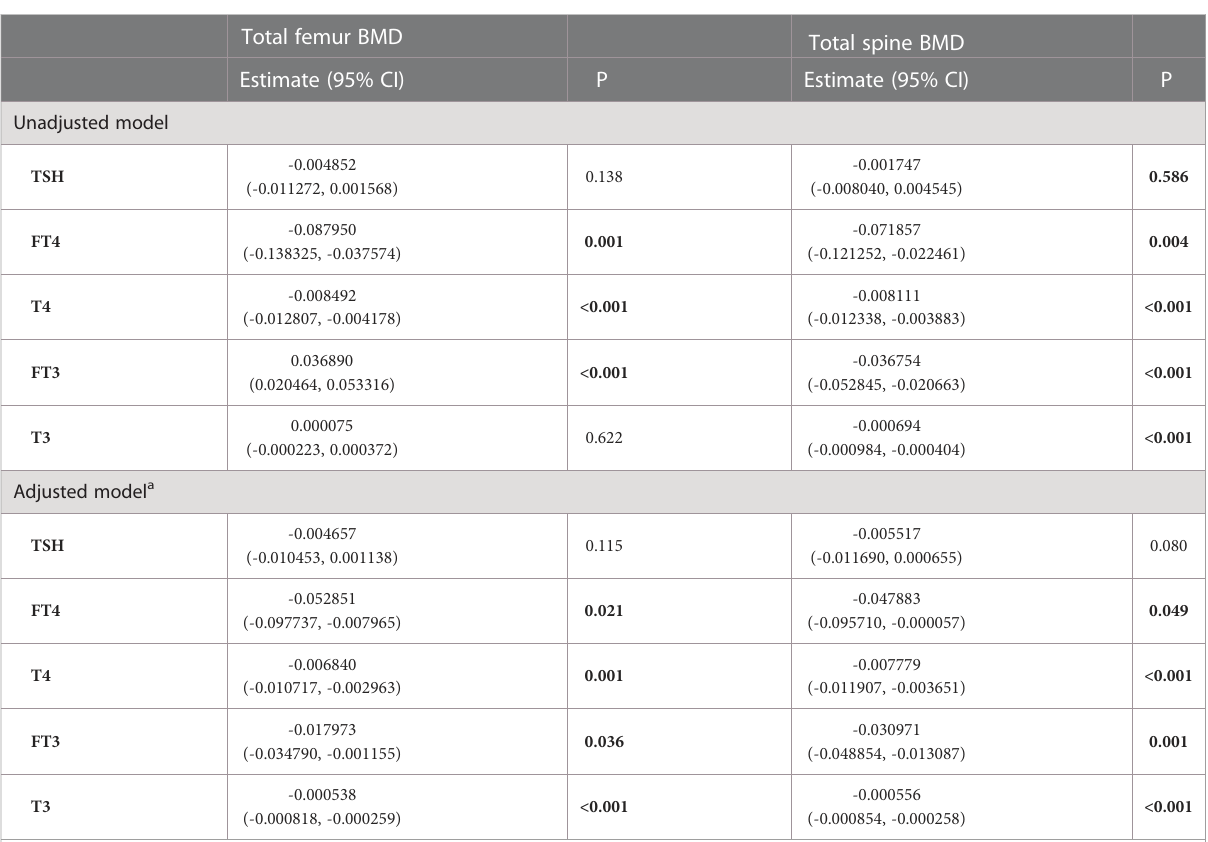
TABLE 3 Association of the thyroid hormone pro fi le with BMD in